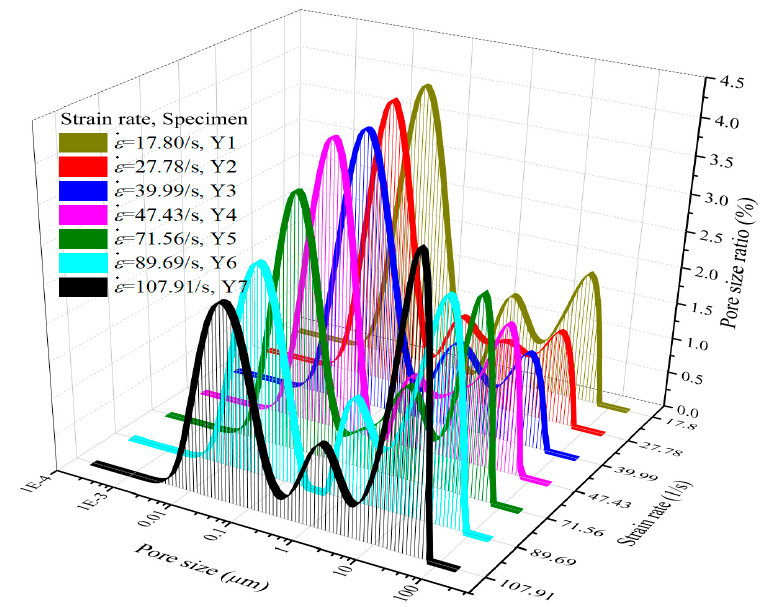
Figure 9. The pore size distribution of Xintian coal specimens (prone) at different strain rates.